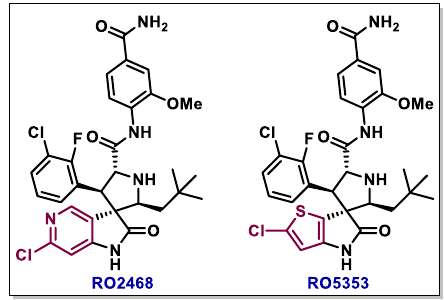
Figure 6. Structure of compounds RO2468 and RO5353, spiroindoline-type inhibitors of p53-MDM2. The pink color in the structures highlights the side chain of the bioisosteric replacements of the 6- chlorooxindole group in RO8994.